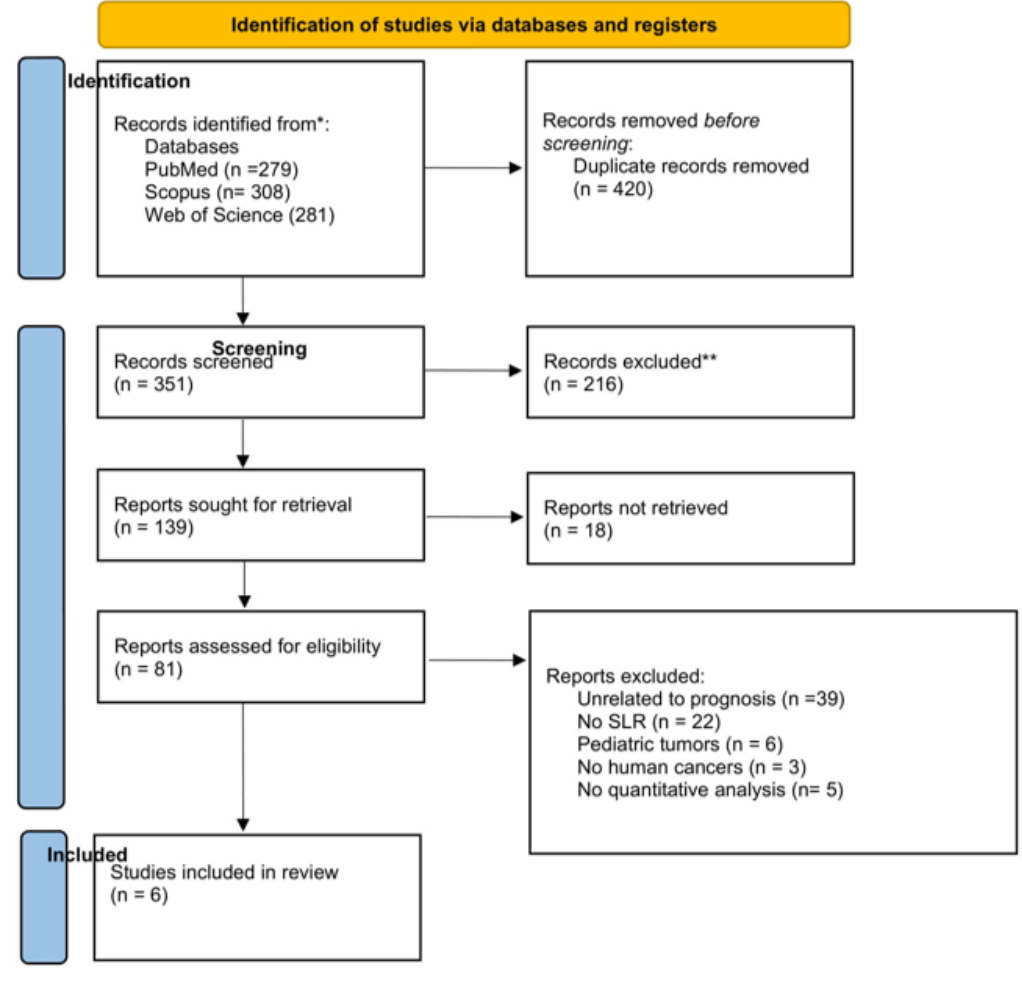
Figure 1. Flowchart of the literature research by database. SLR systematic literature